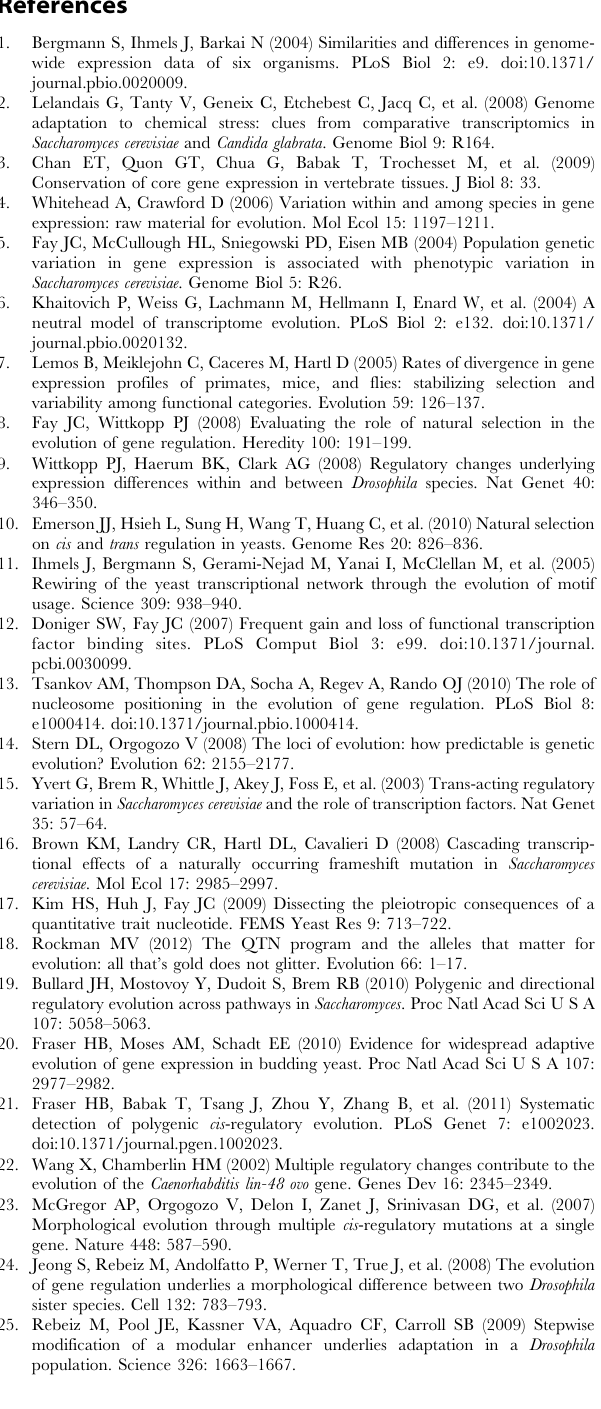
Table S1 Evidence for rate heterogeneity upstream of FZF1 depends on the